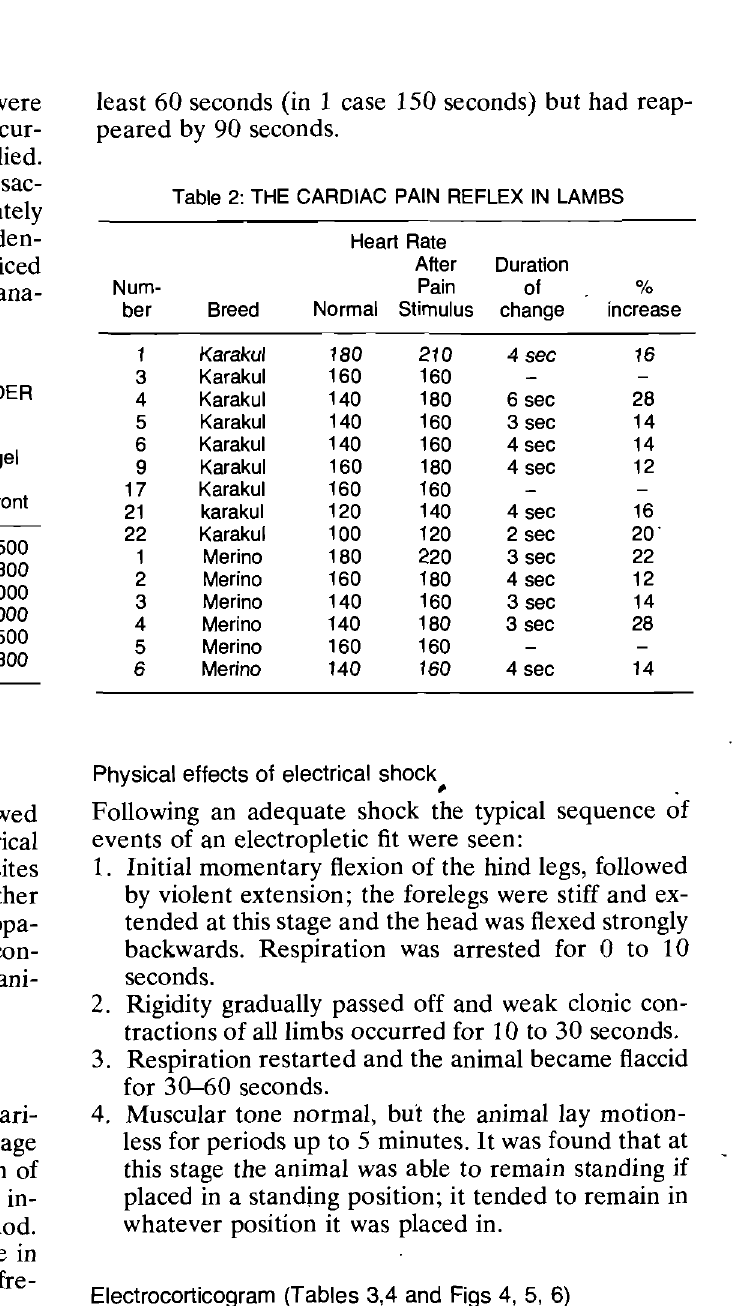
Table 2: THE CARDIAC PAIN REFLEX IN LAMBS